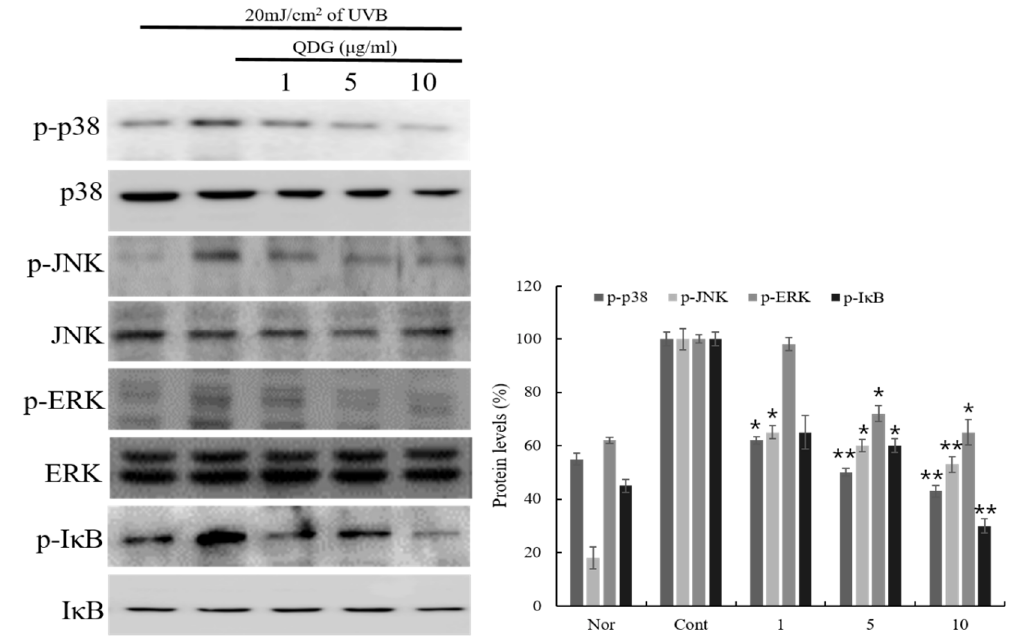
Figure 5. Effects of QDG treatment on mitogen-activated protein kinase (MAPK) phosphorylation expression in HaCaT cells. HaCaT cells were treated with different concentrations of QDG (1, 5, and 10 µ g/mL) after irradiation with 20 mJ/cm 2 UVB. After 30 min, cells were harvested and relative protein levels were determined. Histogram shows the densitometry of phosphorylated-p38, -c-Jun N-terminal kinase (JNK), extracellular signal-regulated kinase (ERK), and inhibitory kappa B alpha (I κ B α ) proteins normalized to GAPDH. Each value represents mean ± SD for the three individual experiments. Nor: No treatment group (0 h), Cont: 20 mJ/cm 2 UVB treatment group, QDG: QDG treated group. n = 3, * = p < 0.001 and ** = p < 0.0001 compared with the control group.